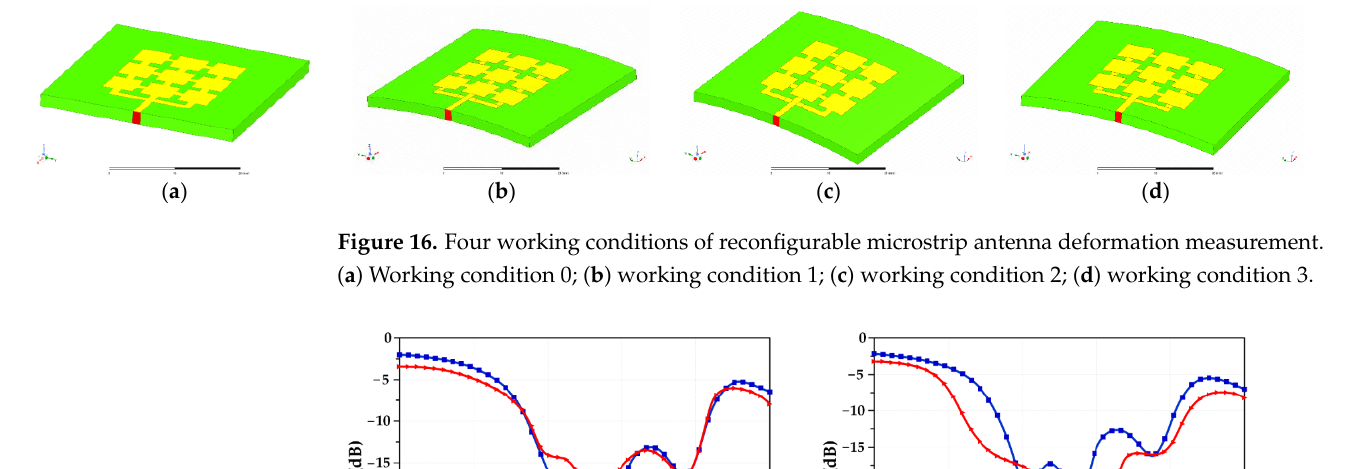
Table 15. Resonant frequencies of the Mode 2 antenna under four working conditions.